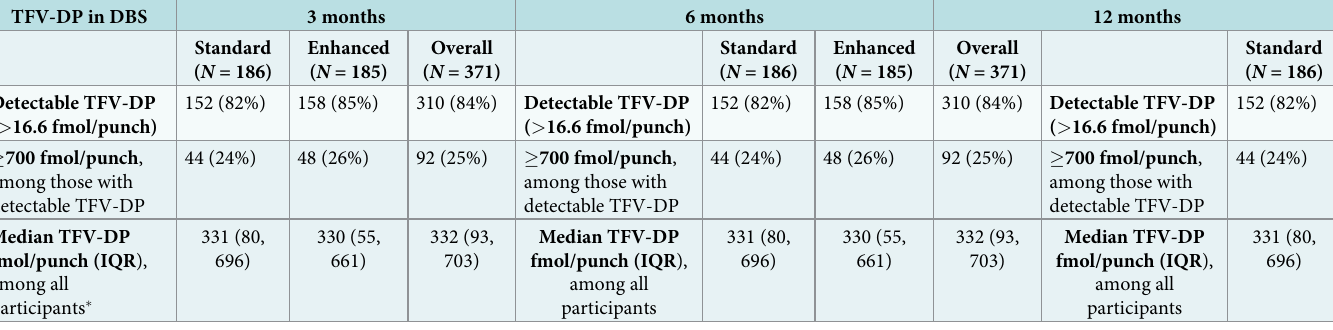
Table 2. PrEP adherence over 12 months by arm and overall, based on TFV-DP concentrations in DBS at months 3, 6, and 12 months, by intervention arm. TFV-DP in